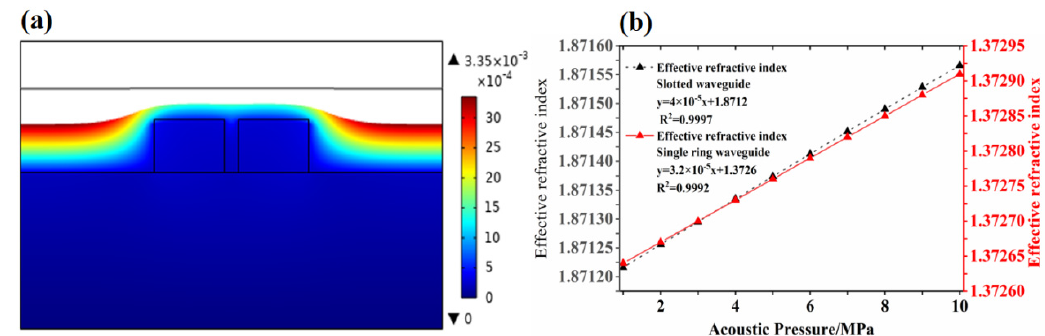
Figure 4. ( a ) Schematic diagram of deformation, and ( b ) the relationship between different sound pressures and the effective refractive index.